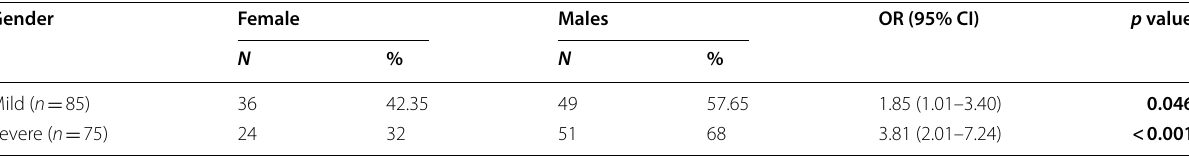
Statistically signficant values are shown in bold N number, % percentage Significant association ( p < 0.05) Table 3 Age-based comparison of COVID-19 severity Age Mild ( n